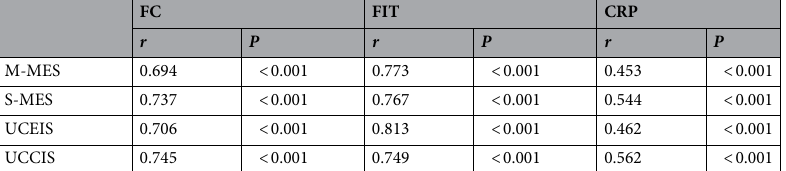
Table 2. Correlations between biomarkers and endoscopic scores. FC Fecal calprotectin, FIT Fecal immunochemical occult blood test, CRP C-reactive protein, r Correlation coefficient, S-MES Sum of Mayo endoscopic subscore, M-MES Maximum Mayo endoscopic subscore, UCEIS Ulcerative colitis endoscopic index of severity, UCCIS Ulcerative colitis colonoscopic index of